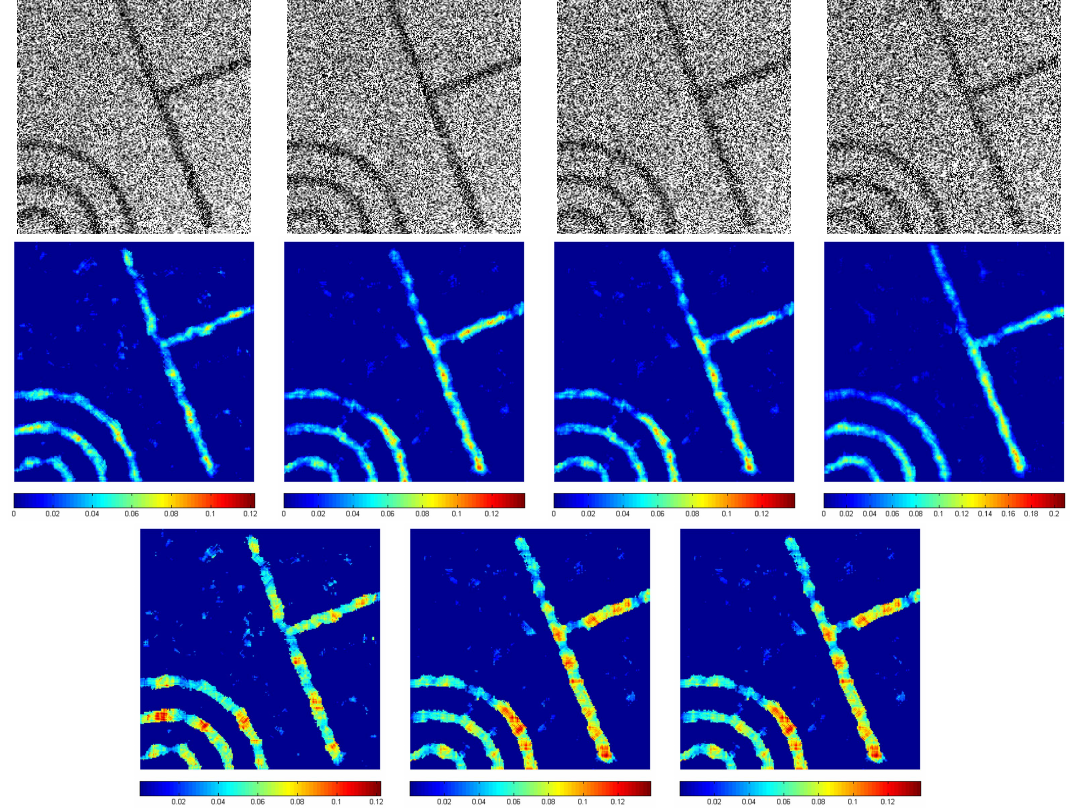
Figure 7. Results obtained on synthetic images with different noise levels. First row, from left to right: Image1 with noise σ = 0 . 45 , Image2 with noise σ = 0 . 55 , Image3 with noise σ = 0 . 65 , Image4 with noise σ = 0 . 75 . Second row: results obtained with the ordinary ANOVA. Third row: results obtained with the modified ANOVA.The colors represent the detection of the methods with the variation of the η 2 parameter.